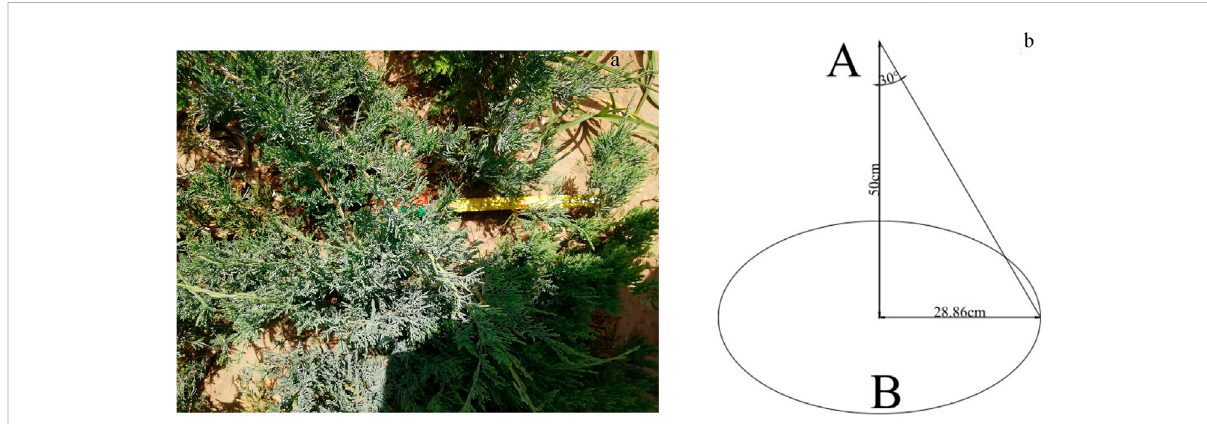
FIGURE 2 Topviewofthemeasuredspectraldata (A) .Schematicdiagramofthespectraldataandchlorophyllcontentmeasurements (B) .PositionAisthe probe position of the spectrometer. Elliptical area B is the area that was monitored by the probe. The probe was 50 cm away from the S. vulgaris canopy.Whenmeasuringthechlorophyllcontent,itwaswithintherangemonitoredbytheprobe.Theradiusofthechlorophyllmonitoringareawas 28.86 cm.